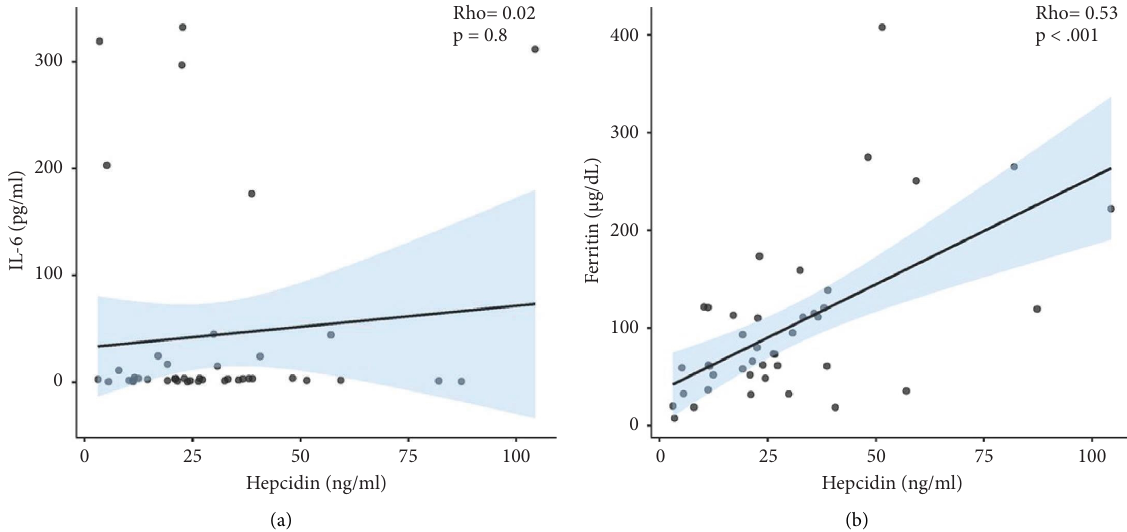
Figure 4: Correlations between hepcidin and IL-6 and ferritin. Te Spearman correlation test was carried out. (a) IL-6 did not correlate with hepcidin (rho � 0.02; p � 0 . 8), but (b) ferritin showed moderate positive correlation (rho � 0.53; p < 0 . 001). IL-6, n � 43; and hepcidin, n �